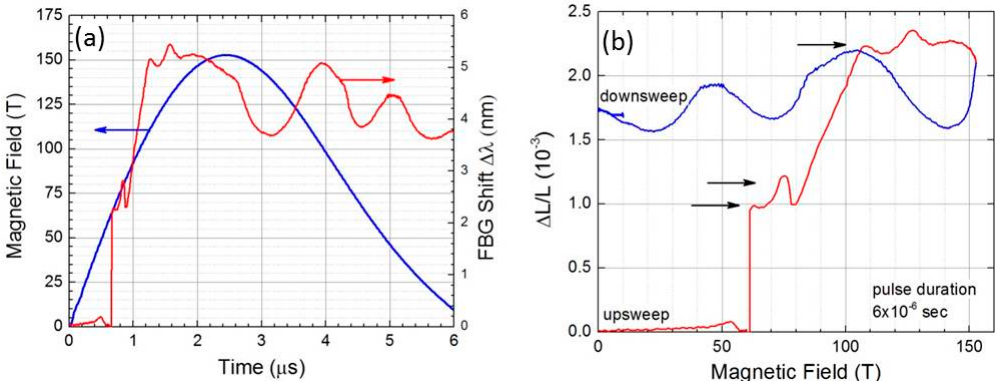
Figure 8. Axial magnetostriction obtained in a destructive 6 microsecond single-turn coil type magnet, figure reproduced from [17]. ( a ). Magnetic field (left y-axis, blue line) and FBG shift (right y-axis, red line) vs. time. ( b ). Computed Δ L/L vs. magnetic field for magnetic field upsweep (red) and down sweep (blue). Spin transitions at 60 T and 75 T, as well as a previously unknown transition at ~106 T, are indicated by arrows.